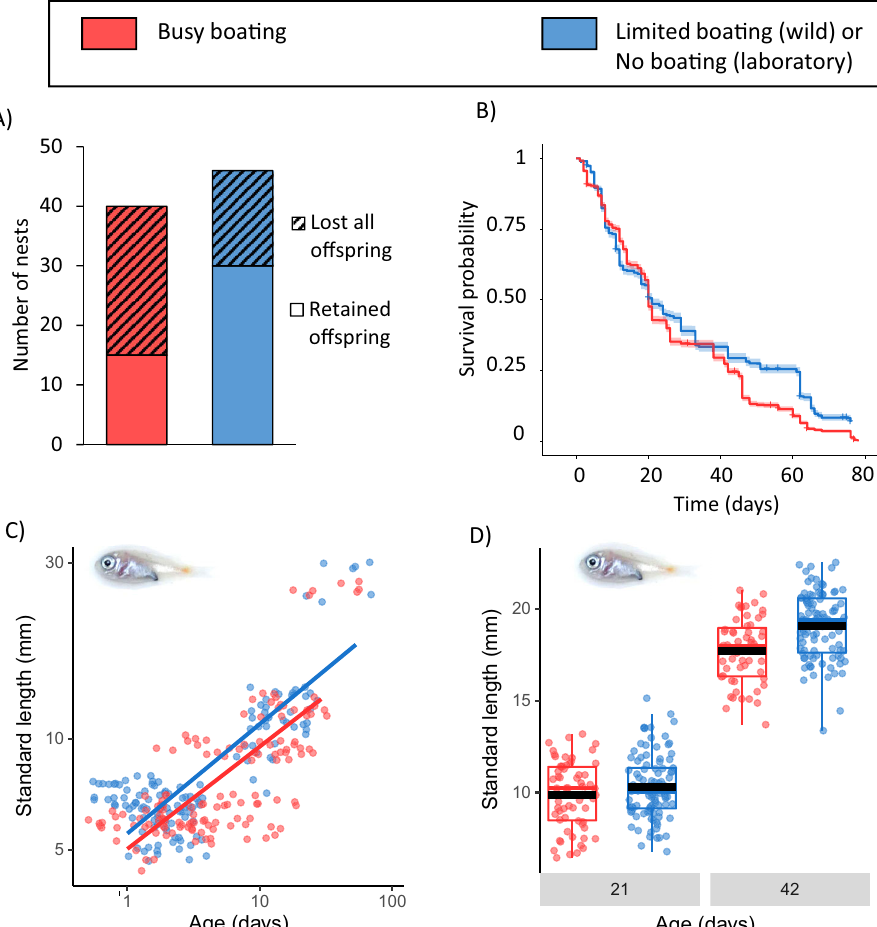
Fig. 1 Difference in juvenile survival and length of spiny chromis exposed to busy boating or protected from motorboat noise. A Likelihood of wild nests that successfully hatched young retaining juveniles at the end of the season (Chi-square test: Χ 2 1 = 4.67, p = 0.031). B Survival of juveniles in the wild from hatching to end of the season (Kaplan-Meier survival curve based on GLM model predictions; Cox survival model used for statistical testing: Χ 2 1 = 34.87, p < 0.001). Busy-boating nests = 32, limited-boating nests = 27). Standard length of 10 juveniles per brood C in the wild (LMM, treatment*age interaction: Χ 2 = 8.97, p = 0.033, effect size mean ± SE = 0.004± 0.001 mm/day, busy-boating nests = 11, limited-boating nests = 11, lines fi tted for illustrative 1 purposes using geom_smooth(method = ‘ lm ’ ) in R) and D in captivity (LMM, treatment*age interaction: Χ 2 1 = 7.95, p = 0.005; effect size of interaction between age and treatment mean ± SE = 0.09 ± 0.04 mm/day, busy-boating broods = 9, no-boating broods = 13, boxes show median and interquartile range (IQR), whiskers extend 1.5 * IQR above or below the box, black bars show